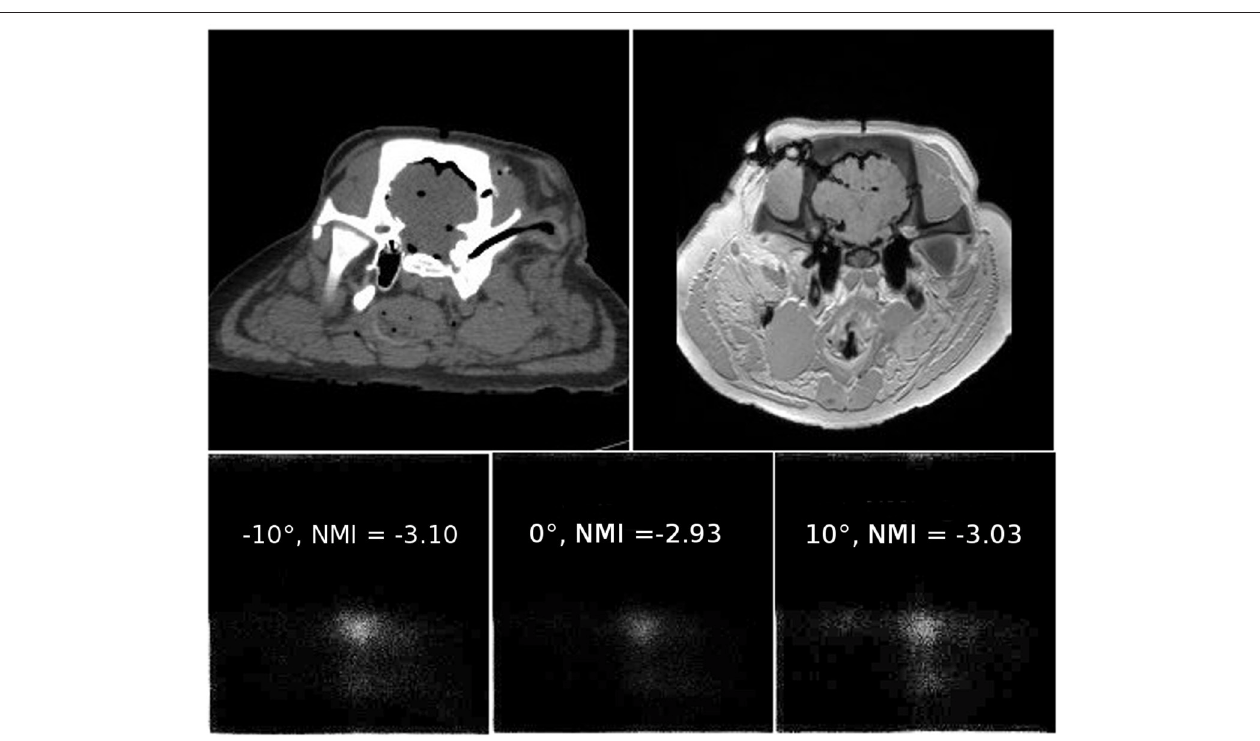
FIGURE 3 | An example of joint histograms and related normalized mutual information values. The two upper images show roughly co-registered slices of a porcine cadaver specimen plus additional soft tissue deformation which was not accounted for. The left image was taken using a 64 slice CT, and the right image is a T1-weighted image from a clinical 3T scanner. Details on the image dataset can be found in Pawiro et al. [ 68]. The MR image was rotated by 10 ◦ clockwise, and the resulting joint histogram is shown in the lower left corner of the illustration. Joint histograms are counting statistics where the occurrence of a gray value at the same image element position in the two images under comparison is logged; the abscissa indicates bin locations for all possible gray values in the first image, often referred to as I Base –the base image. The ordinate holds bins for all gray values of the second image to be matched—I Match . The more bins occupied with low total counts, the bigger the entropy in the joint histogram. Normalized mutual information reaches a maximum of − 2.93 when the relative rotation of the images is 0 ◦ . For relative rotation of ± 10 ◦ , visual inspection shows that more bins are obviously occupied, leading to a higher entropy in the histogram. The dataset is available from https://